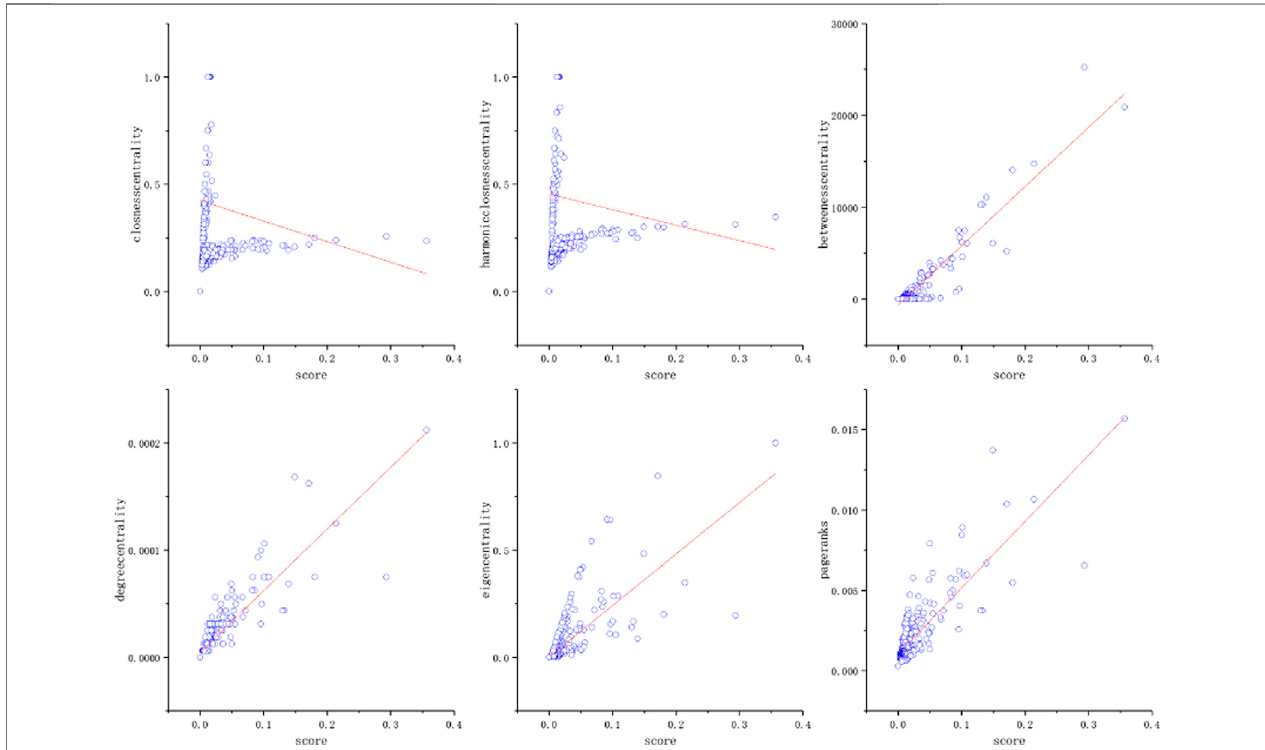
FIGURE 11 | The relationship between node strength and different centrality values.